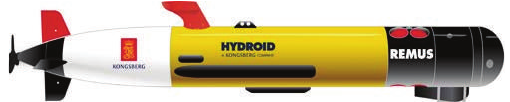
Figure 1: REMUS AUV (image credit: Kongsberg Maritime).